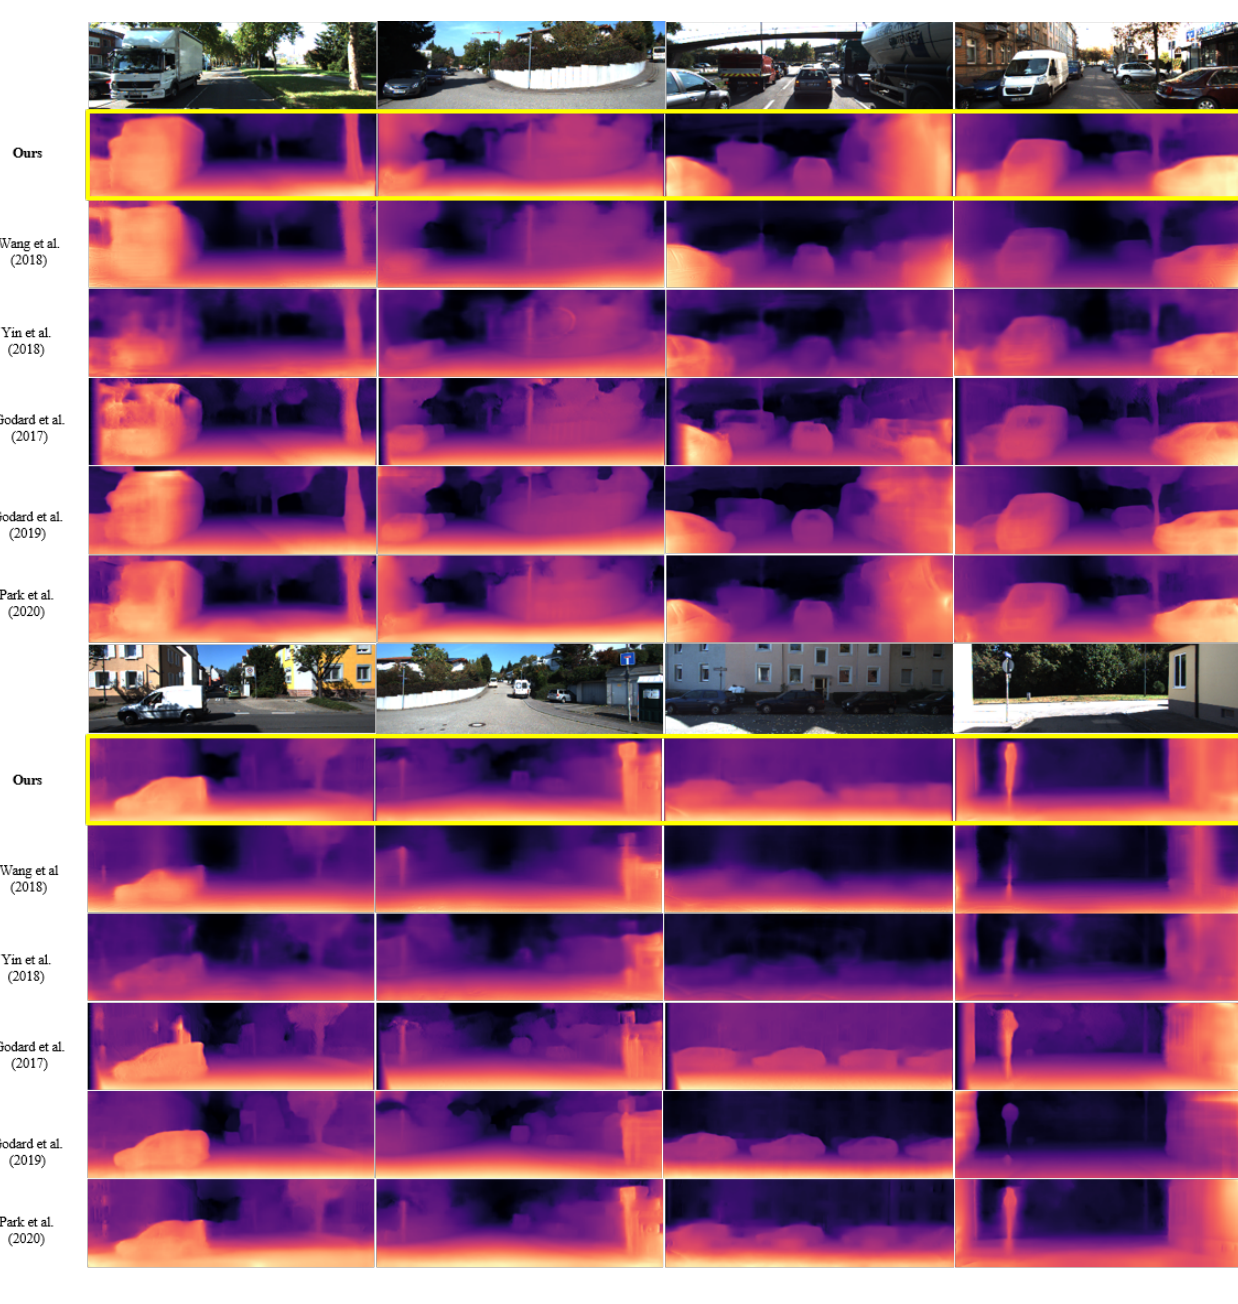
Figure 2. Qualitative results: comparison with several representative unsupervised learning-based models (Wang et al. (2018) [25], Yin et al. (2018) [24], Godard et al. (2017) [6], Godard et al. (2019) [1], Park et al. (2020) [7]). Table 3. Ablation study for analyzing the effectiveness of our perceptual loss. (In the table, "Smooth" represents the smoothness